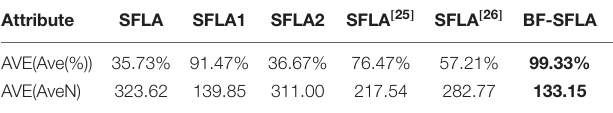
TABLE 5 | The index mean value under fixed optimization accuracy. Attribute